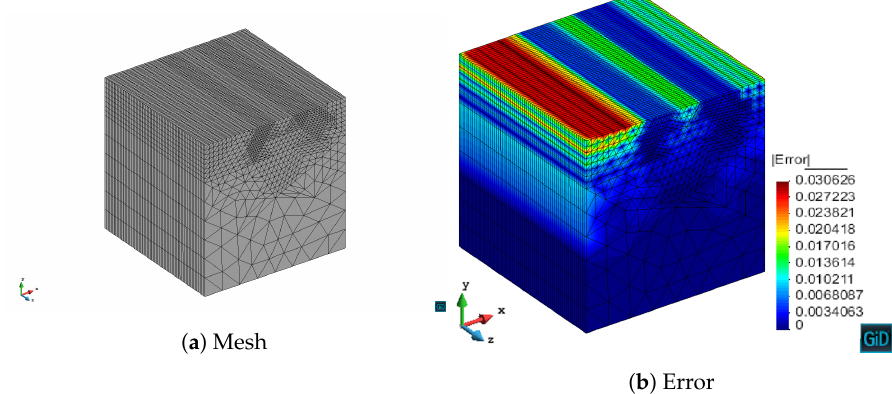
Figure 13. Approximation of (13) using the SER marking